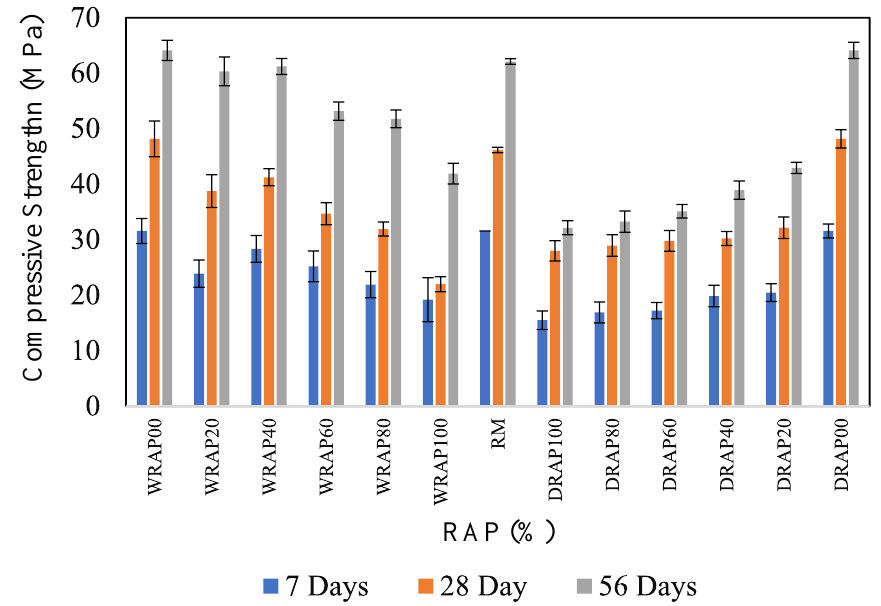
Figure 5. Influence of Compressive Strength in DRAP and WRAP-based Concrete.